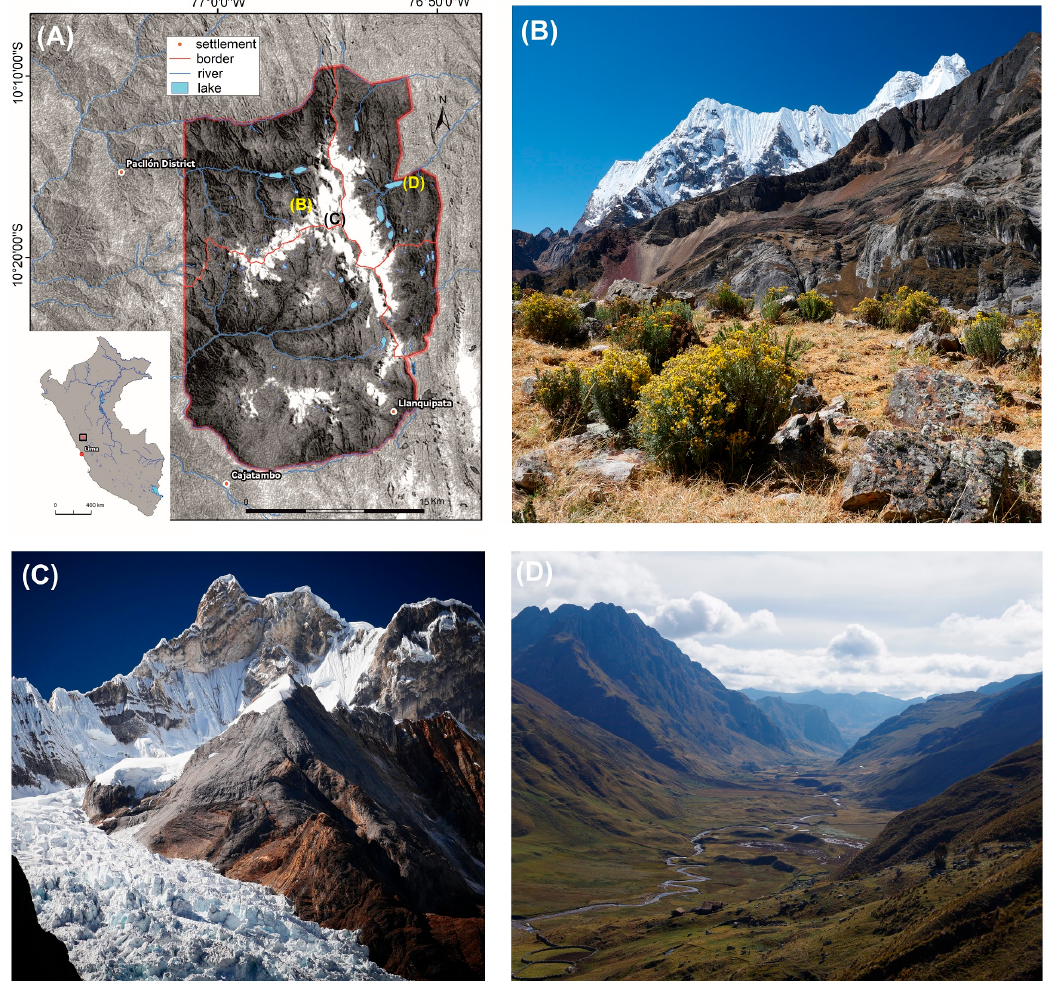
Figure 1. Study area. ( A ) The location of the study area Cordillera Huayhuash in Peru; ( B ), ( C ) and ( D ) diverse environmental conditions in different parts of the study area (for location see ( A )). Field images were taken in 2018 and 2019 by AE.